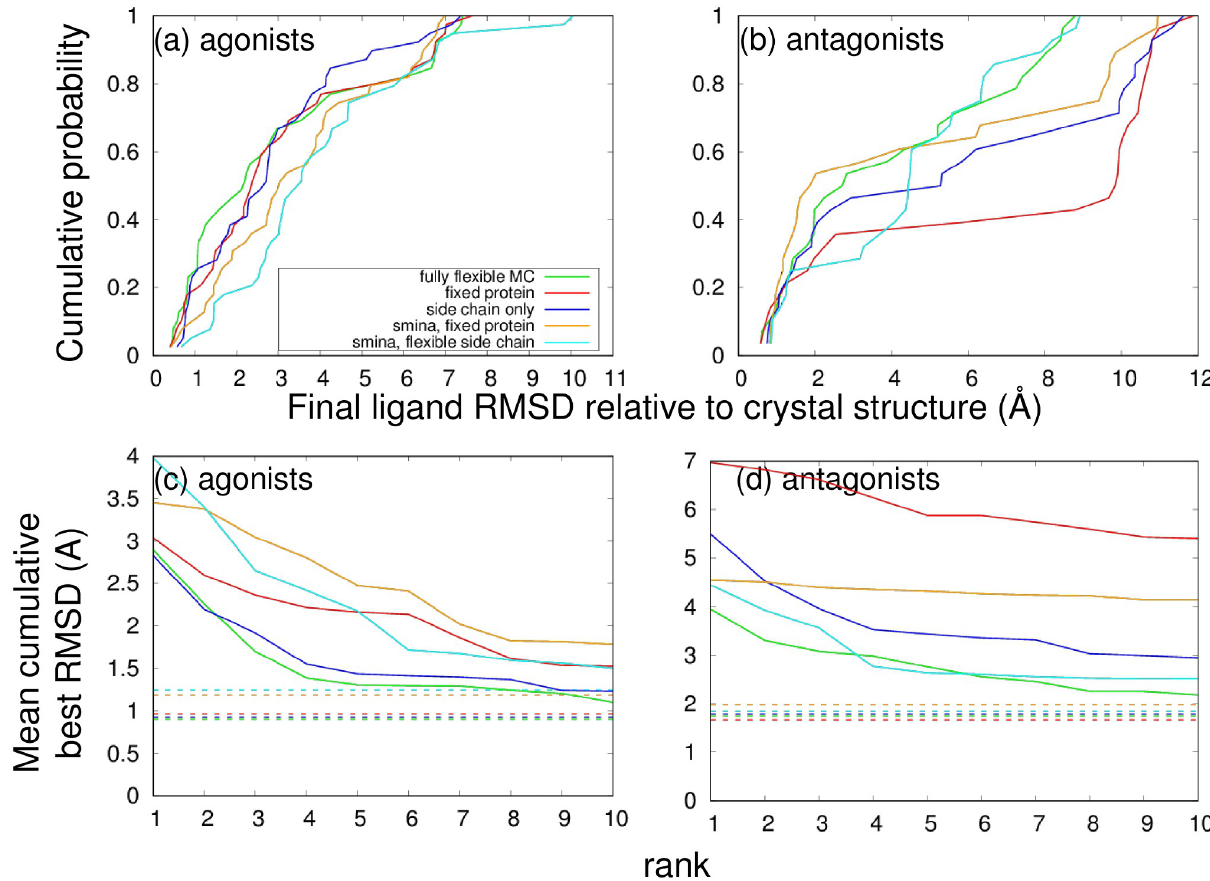
Fig 8. Performance comparison of MRMC with Autodock smina. Plots are similar to those shown in Fig 6. (a) and (b) show the cumulative probability distribution of RMSD values for the docked poses with the lowest final interaction energies for each drug, for (a) agonists or (b) antagonists. Larger values at low RMSD indicate better performance. In (c) and (d), for each drug the docking runs with the N lowest interaction energies are chosen and the best RMSD from among these is averaged across (c) agonists or (d) antagonists, so that lower RMSD indicates better performance. This average RMSD is plotted against N ; dashed horizontal lines indicate the average best RMSD overall, without regard for interaction energy.